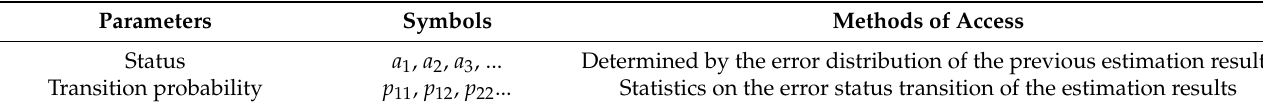
Table 1. Relevant parameters of the Markov chain. Parameters Symbols Methods of Access Status a 1 , a 2 , a 3 , ... Determined by the error distribution of the previous estimation results Transition probability p 11 , p 12 , p 22 ... Statistics on the error status transition of the estimation